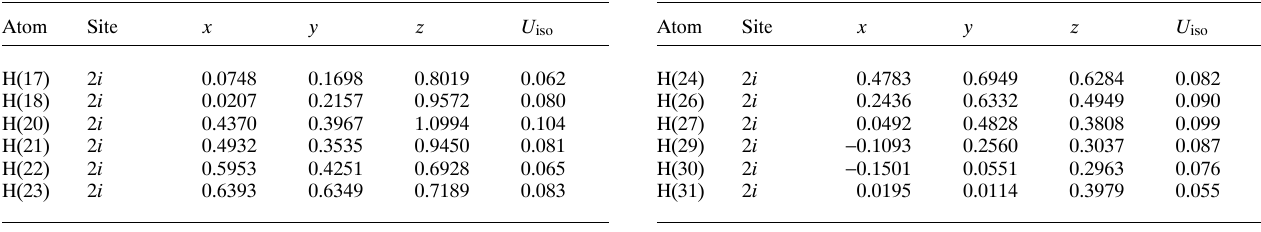
Table 2. C ontinued .